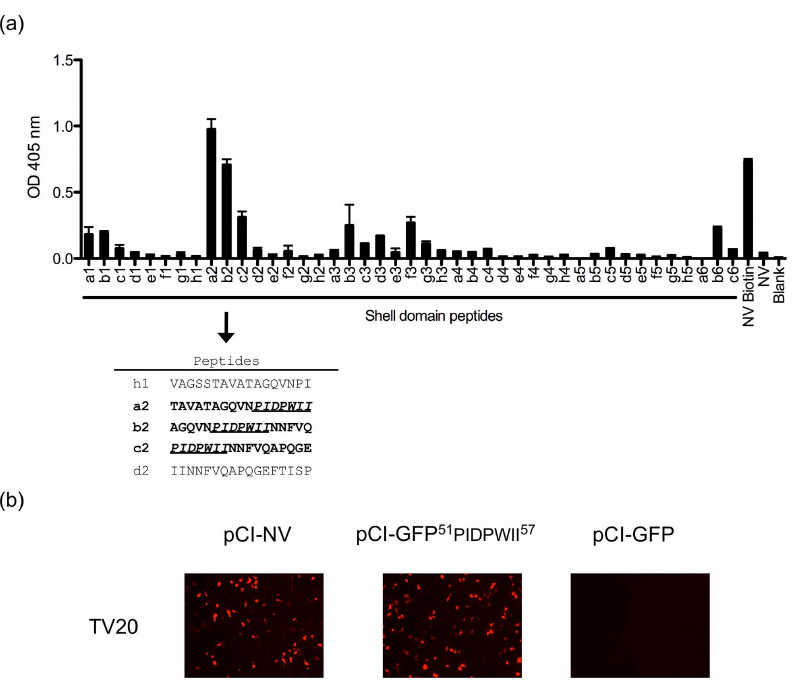
Figure 2. MAb TV20 binds to the Shell domain of the capsid protein. (A) Reactivity of MAb TV20 with library of peptides corresponding to the Shell domain of NV. Positive peptides span residues 41–67 from NV VP1 protein. The common residues of the three positive peptides are underlined. (B) Reactivity of MAb TV20 with cells expressing the putative epitope (residues 51–57) fused at the C-terminus of the green fluorescent protein. Experiments were performed as described in Materials and Methods .